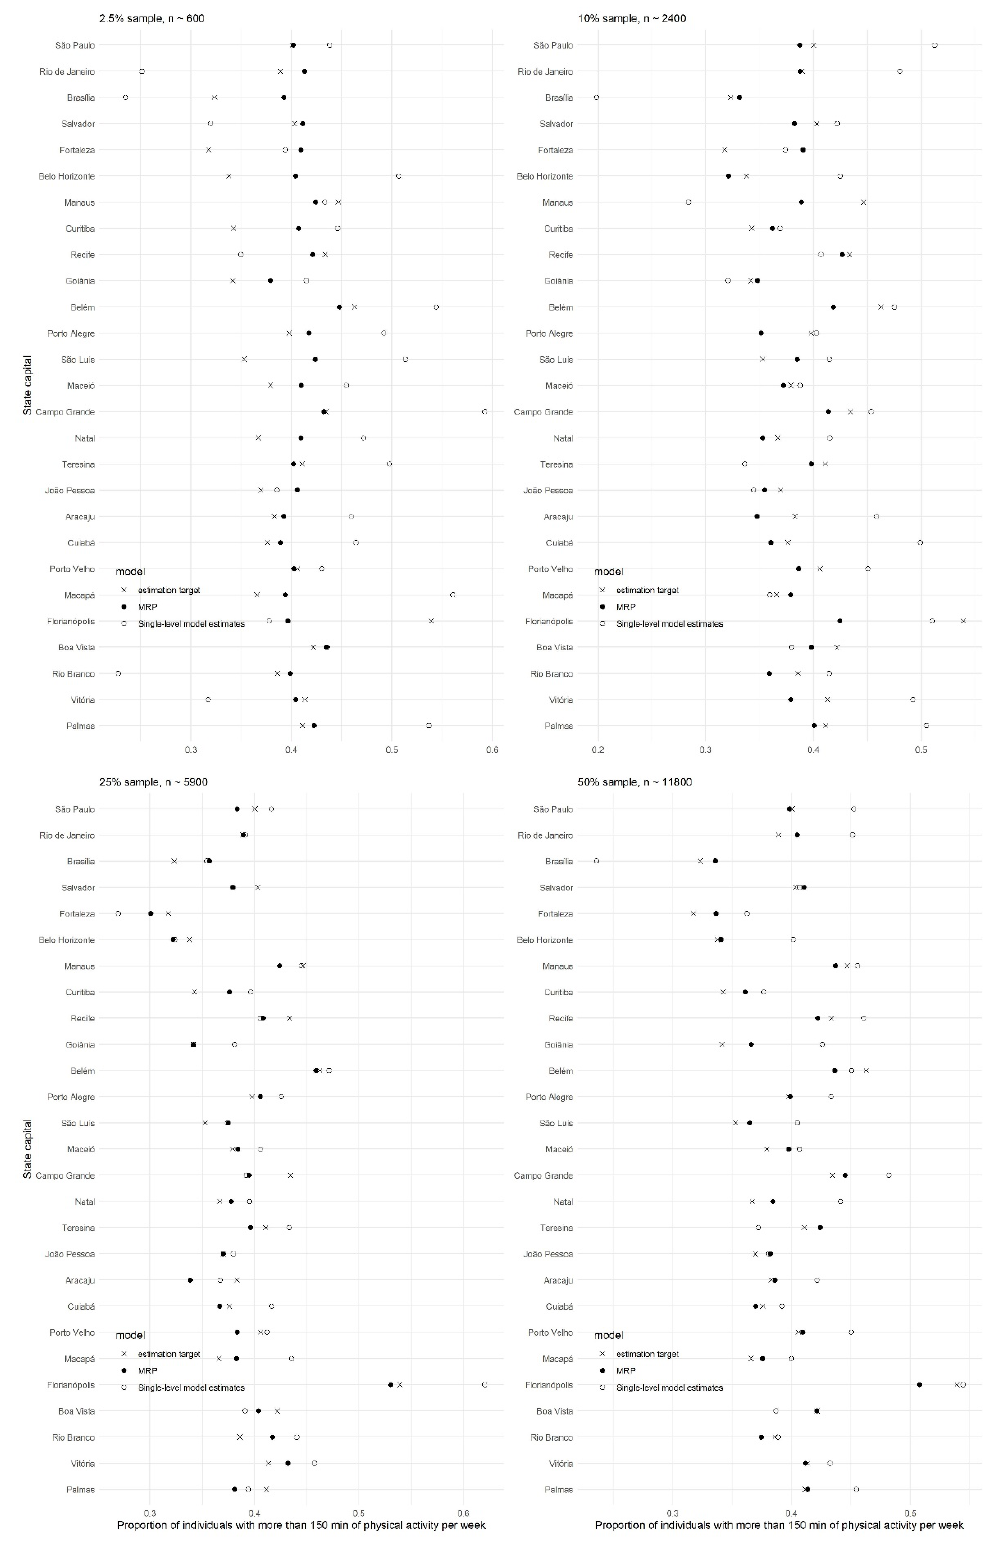
Figure 1. Cross-validation—estimation target (“true value”) against MRP and single-level regression model, and subsample size.